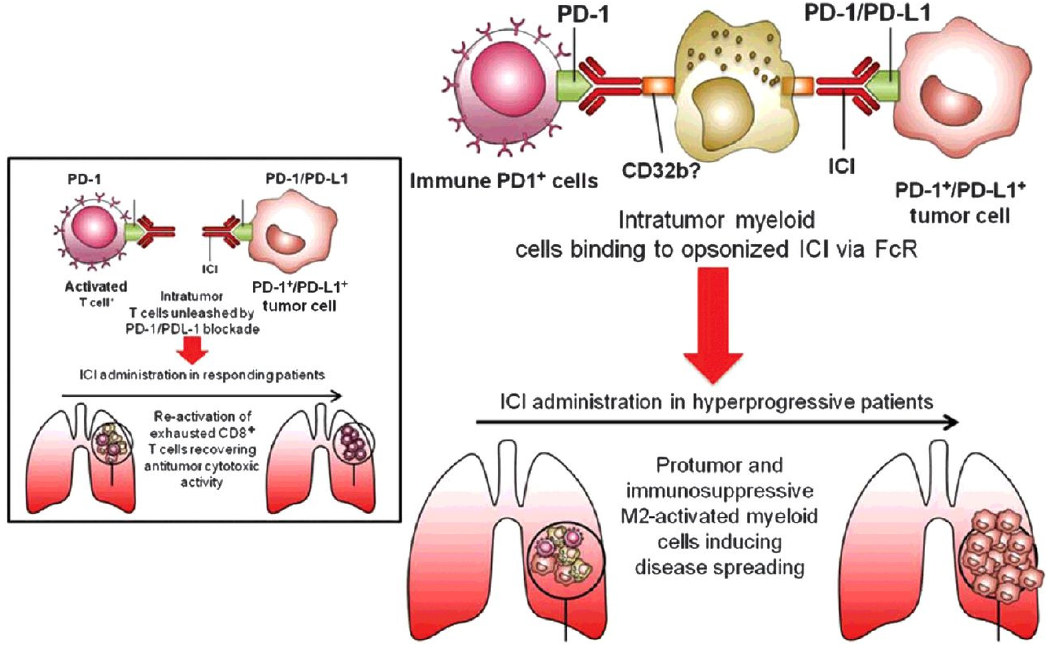
Figure 2. Hypothesized mechanism through which macrophages and ICIs are involved in HPD de- velopment. Reprinted with permission from Ref. [10]. 2019, American Association for Cancer Re- search.